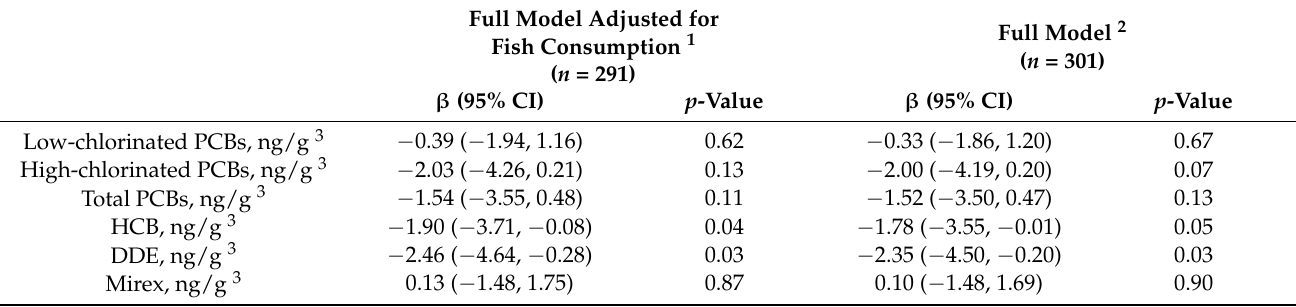
Table 3. Results of linear regression for DSST regressed on log-transformed low-chlorinated PCBs, high-chlorinated PCBs, total PCBs, HCB, DDE, and mirex, adjusted for confounders (sin- gle pollutant